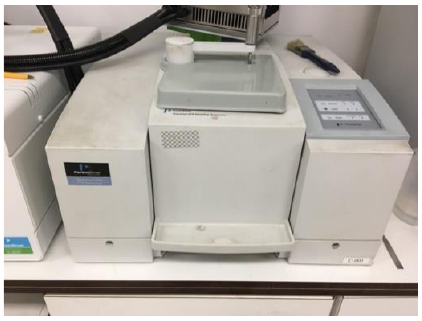
Figure 4. FTIR Spectrometer.